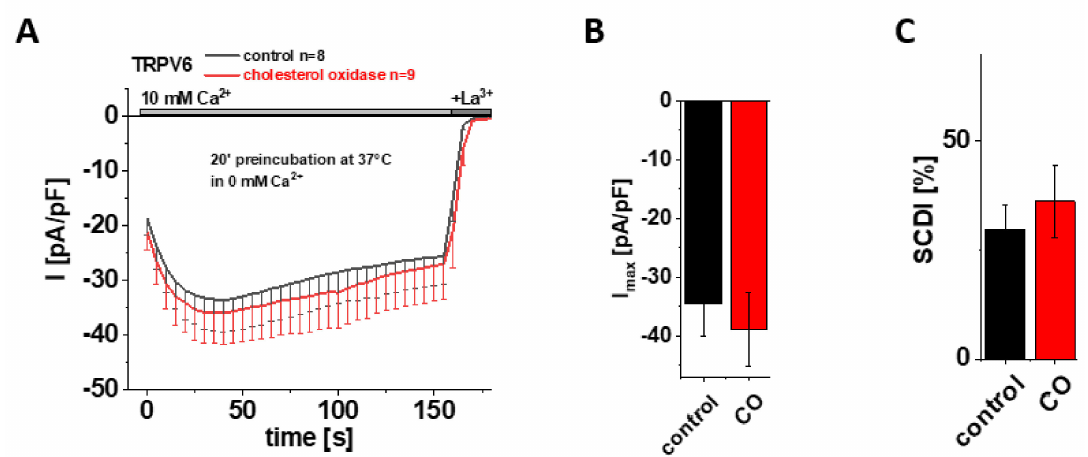
Figure 3. Preincubation with cholesterol oxidase (CO) has no effect on maximum currents and SCDI of TRPV6 WT. ( A ) Averaged time course of whole-cell currents (mean ± SEM) recorded from HEK 293 cells expressing TRPV6 WT. Cells were preincubated in 0 mM Ca 2+ extracellular solution with (red) and without (control, black) 2 U/mL CO at 37 ◦ C for 20 min. Measurements were carried out in 10 mM Ca 2+ extracellular solution and currents were blocked by 1 mM La 3+ at the end of the experiments, as indicated by the grey bars. ( B ) Block diagram of maximum currents according to measurements in ( A ). ( C ) Block diagram of the extent of SCDI in % according to measurements in ( A ). There is no statistical significance ( p < 0.05) in comparison to TRPV6